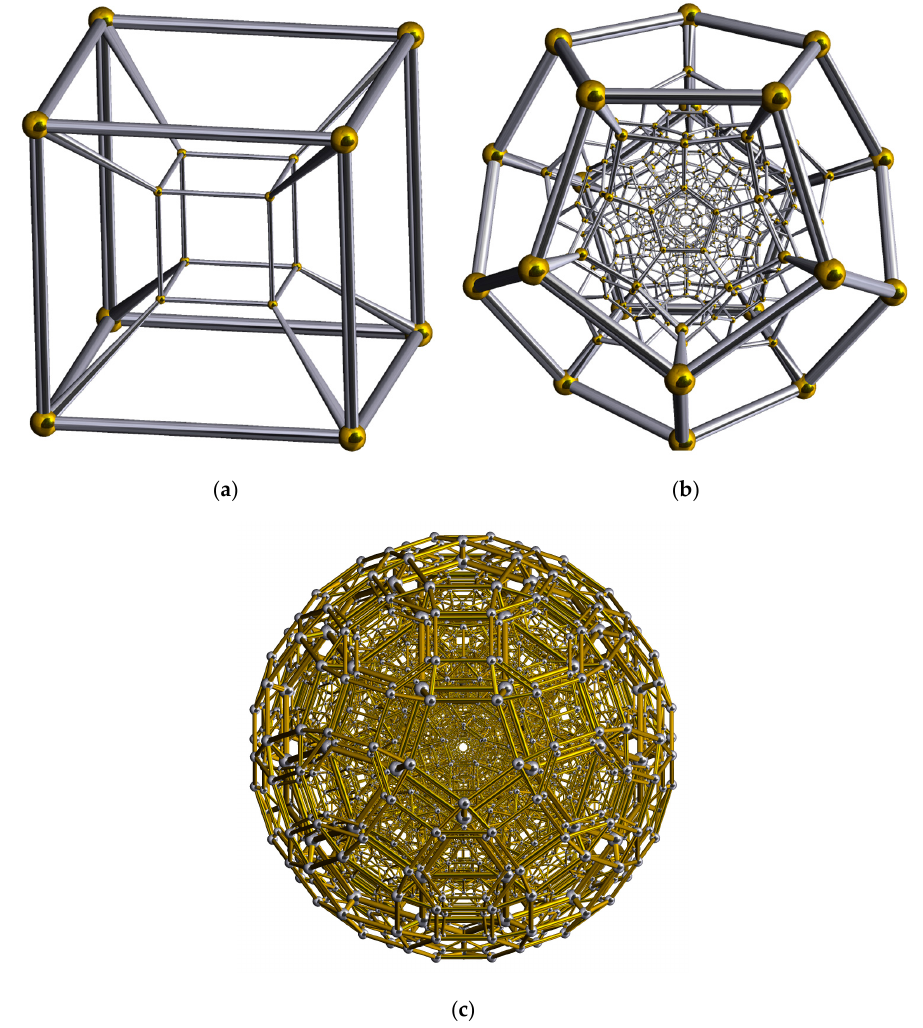
Figure 2. Three 4D objects of differing complexity: a tesseract, which has 8 cells ( a ); a dodecacontachoron, which has 120 cells ( b ); and a prismatorhombated hecatonicosachoron, which has 2640 cells ( c ). Images from Robert Webb’s Stella Software (www.software3d.com/stella.php).